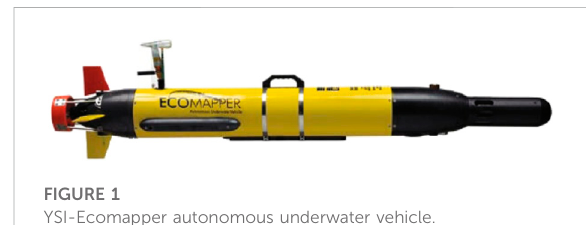
FIGURE 1 YSI-Ecomapper autonomous underwater